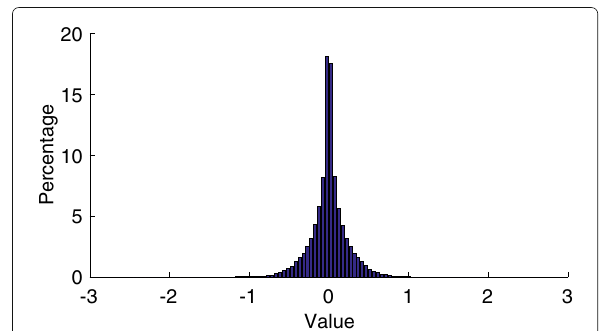
Fig. 8 Coefficient values with experimental data. The distribution of the real and imaginary parts of the coefficients found by CSIApx is shown for the strongest antenna pair in the each experimental test case